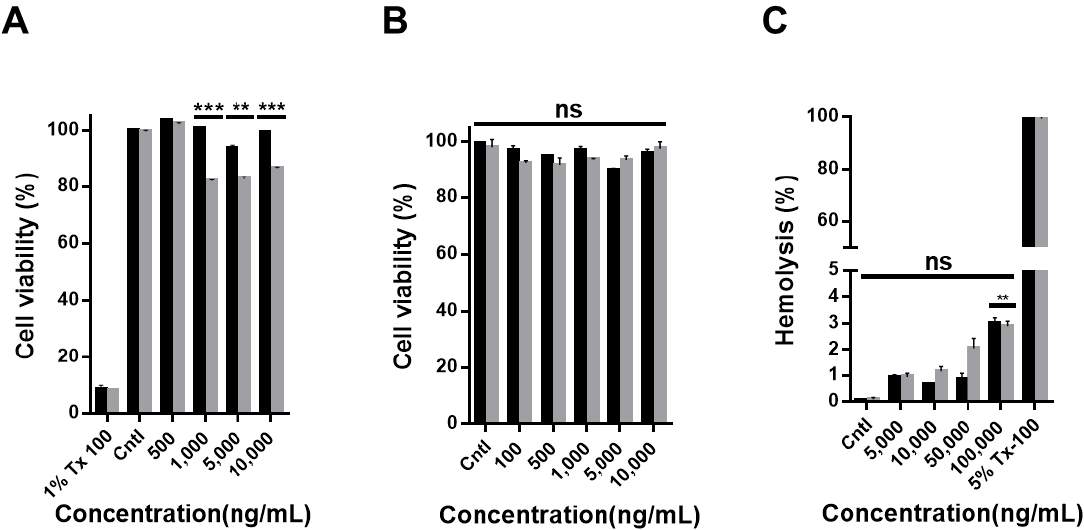
Figure 2. Cytotoxicity test of CNO (black bar) and CNO–COOH (gray bar) on human dermal fibroblast (HDF) cells and peripheral blood mononuclear cells (PBMCs). CCK-8 assay of treated samples incubated with varying concentrations (100, 500, 1000, 5000, and 10,000 ng / mL) of CNO and CNO–COOH with ( A ) HDF cells, and ( B ) PBMCs; ( C ) percent hemolysis of red blood cells incubated with varying concentrations (5000, 10,000, 50,000, and 100,000 ng / mL) of CNO and CNO–COOH.